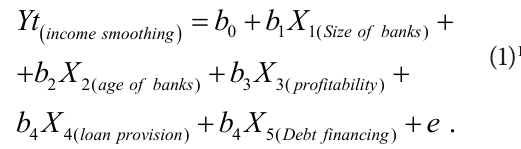
Figure 1. Eckel’s model